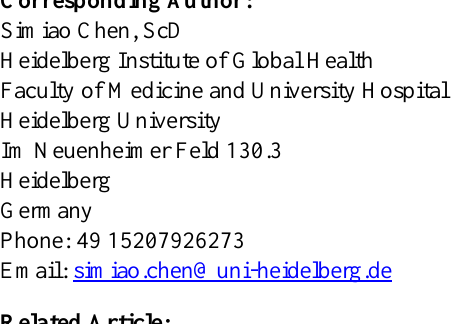
Figure 1: Map showing the mean overall knowledge score by province. Supplementary Figure A3: Map showing the mean overall knowledge score by province when excluding participants who reported looking up an answer online (Multimedia Appendix